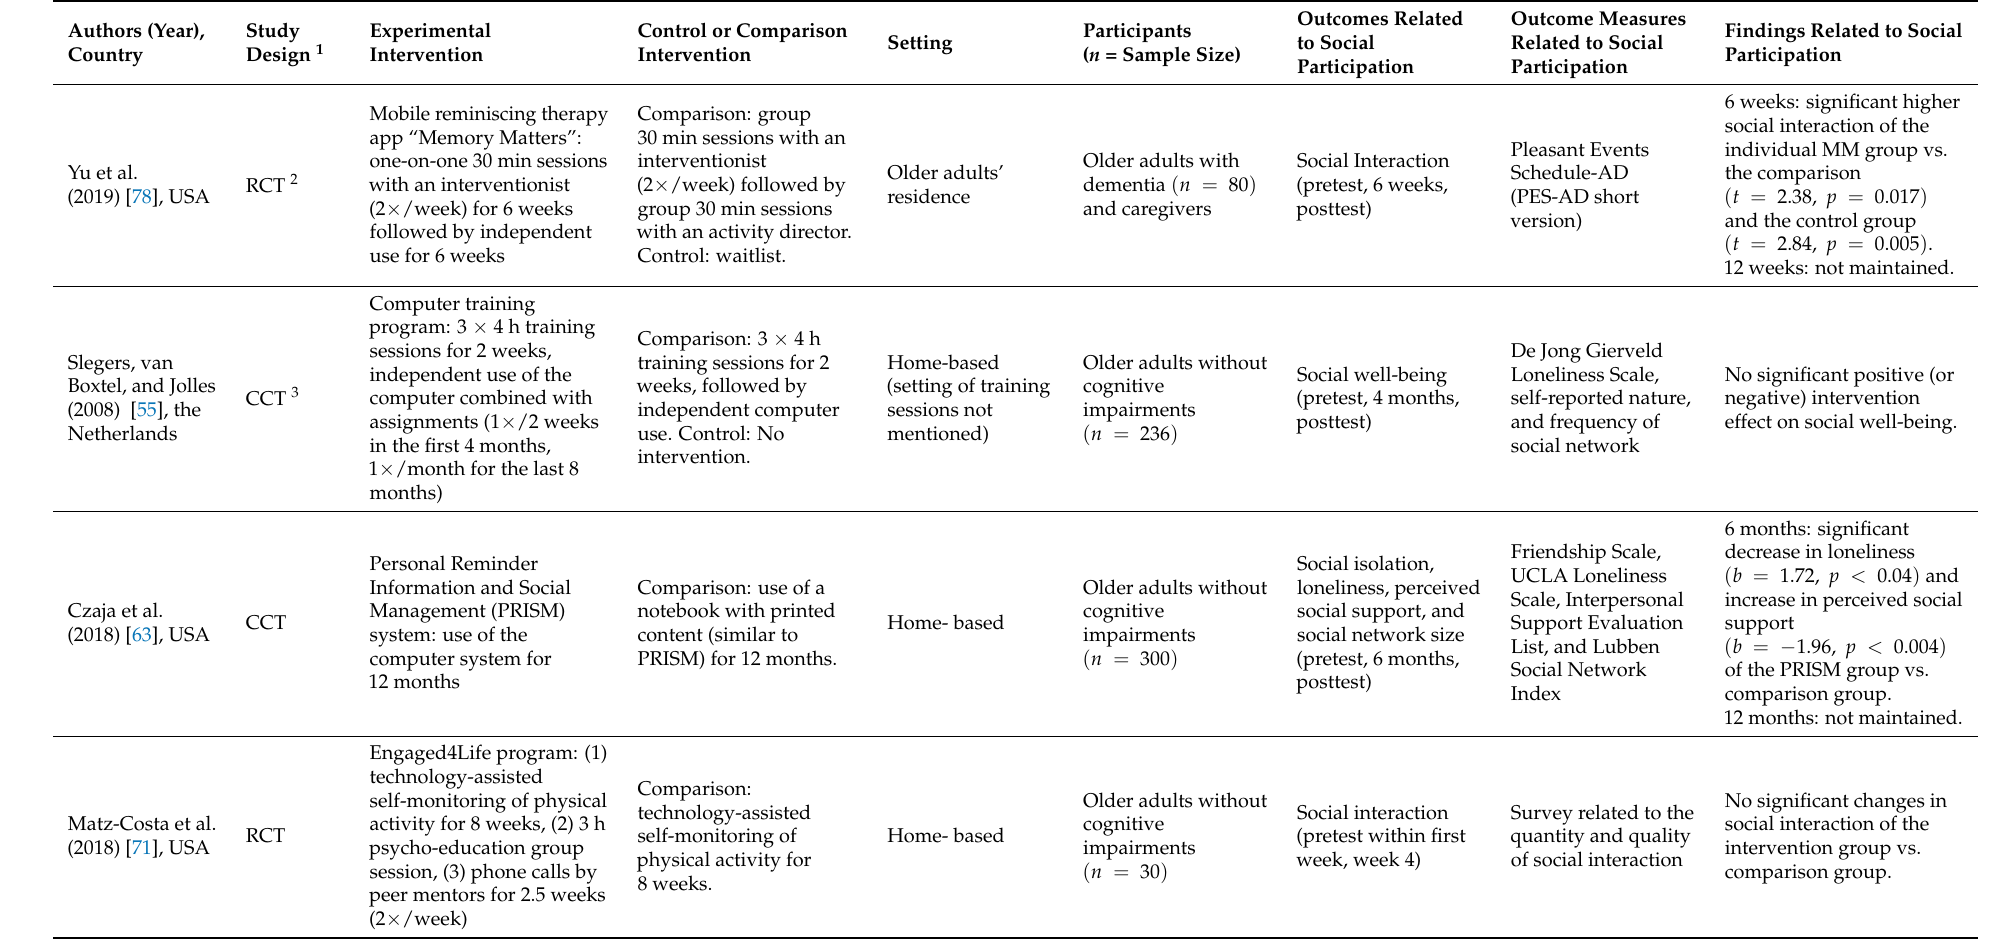
Table 5. Design, methods, and findings related to social participation reported from included quantitative